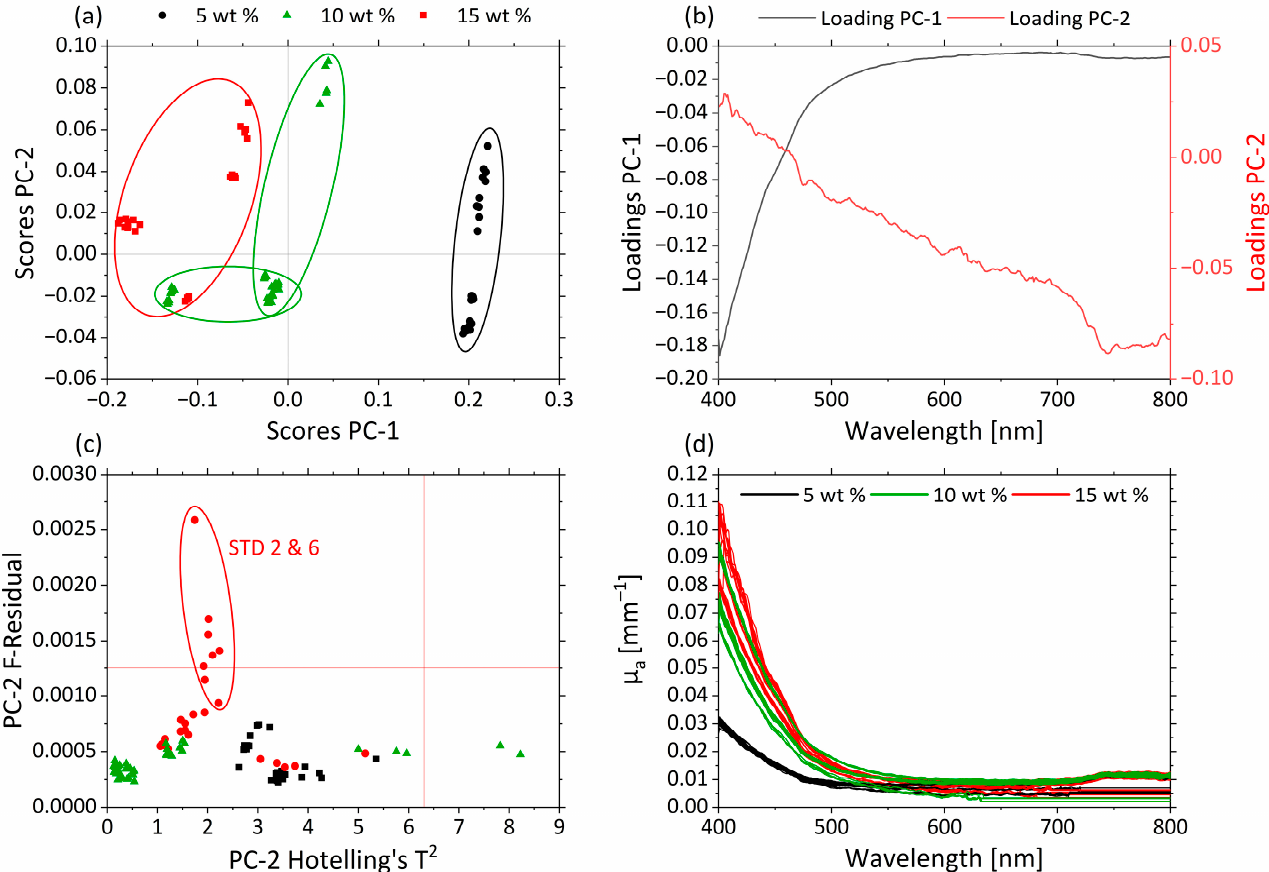
Figure 5. PCA and spectra of µ a . ( a ) Scores plot with MWF concentration 5 wt% (black circle), 10 wt% (green triangle) and 15 wt% (red square) for PC-1 against PC-2. ( b ) Corresponding loadings PC-1 (black) and PC-2 (red). ( c ) Influence plot Hotelling’s T 2 versus F-residuals for PC-2. ( d ) µ ’ s -spectra of MWF concentration 5 wt% (black), 10 wt% (green) and 15 wt% (red).